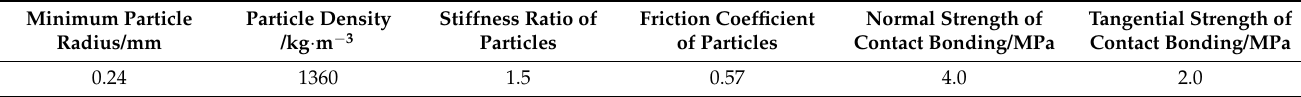
Table 4. Micro-parameters of numerical model.